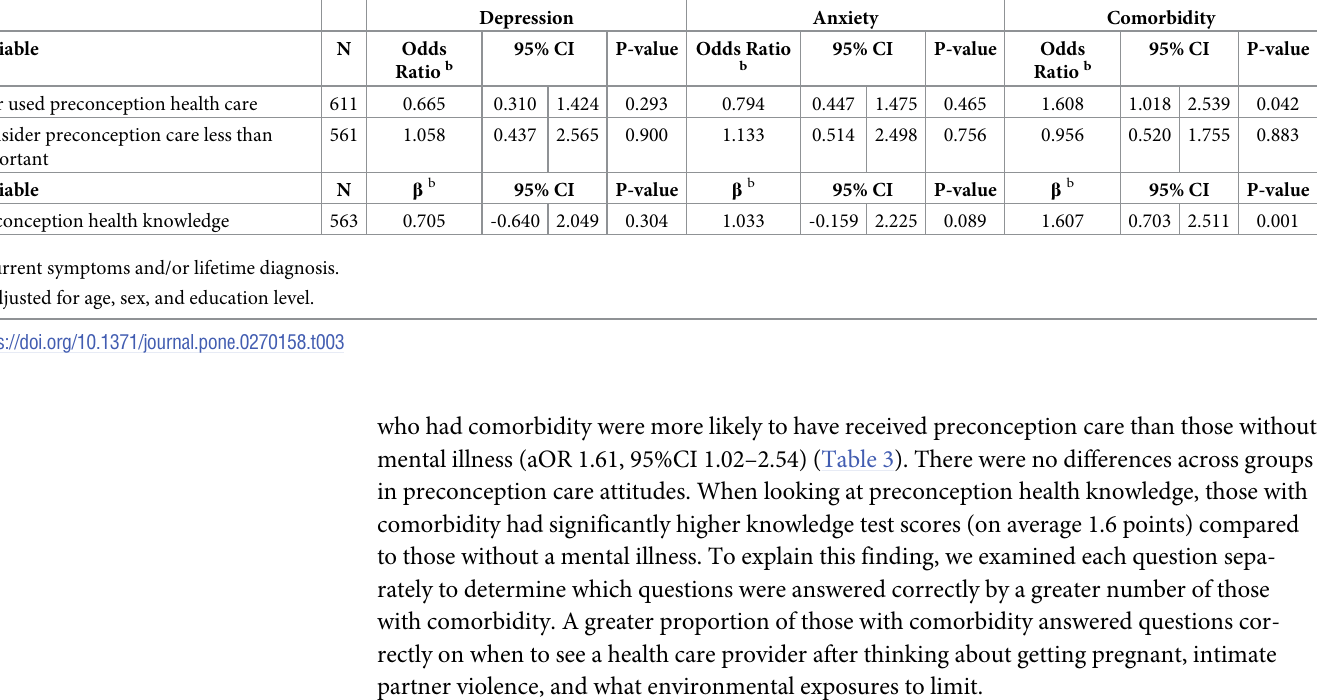
Table 3. Preconception health care use, attitudes, and knowledge among individuals with depression, anxiety, and comorbidity compared to those without mental illness a